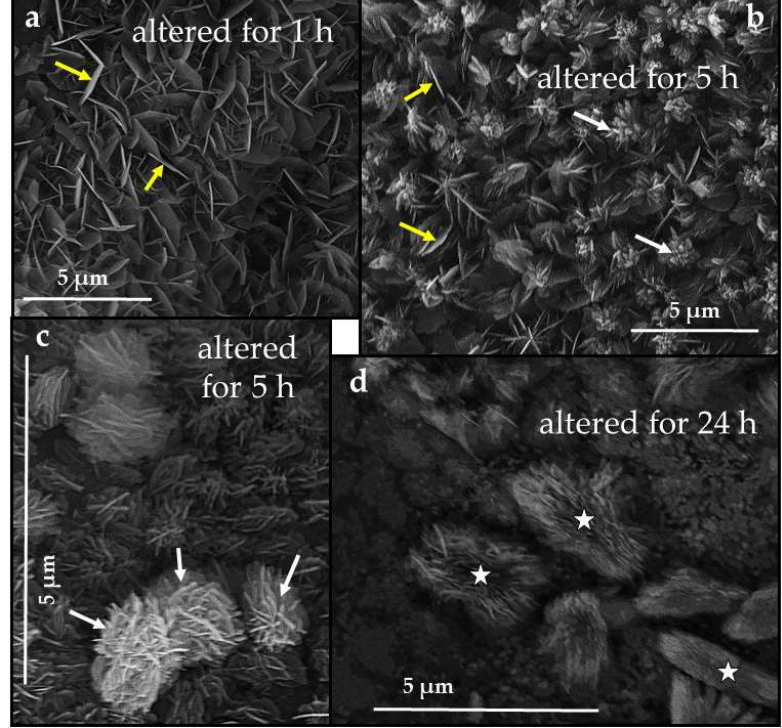
Figure 9. FE-SEM images showing the change in AP crystal morphology with progressive conversion of Sepia officinalis cuttlebone aragonite. ( a ) Conversion for 1 h; ( b , c ) conversion for 5 h and fusion of individual crystals; ( d ) fusion of some AP crystals and densification of the AP cover.